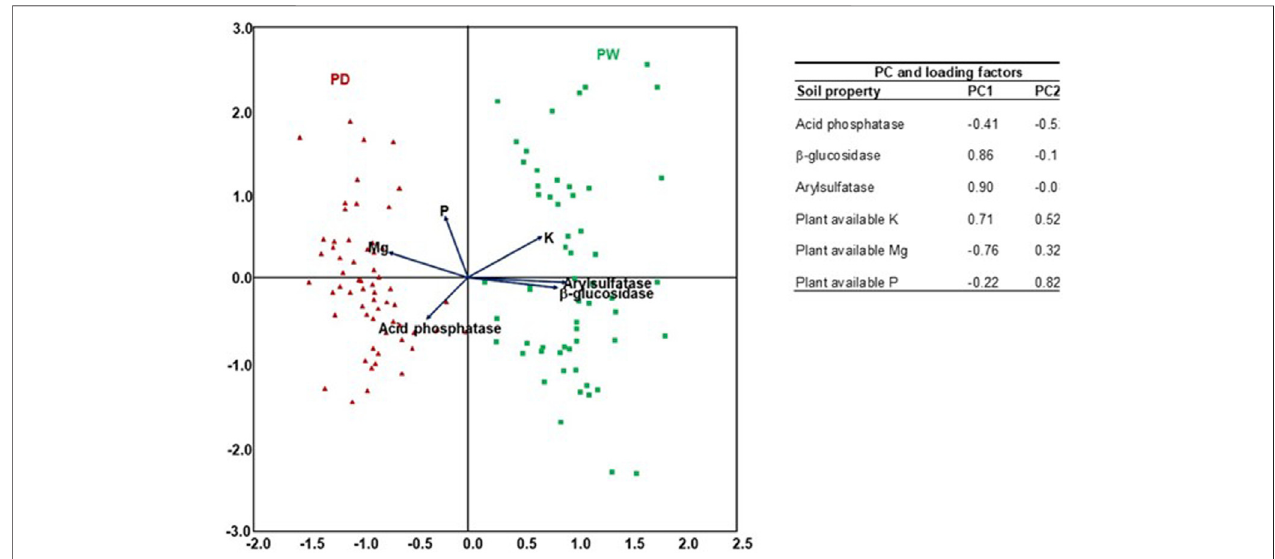
FIGURE4| PCAscatterplotofplantavailablenutrientconcentrationandenzymeactivityinthesurfacehorizonsofthedrainedandrewettedpeatlands.PD:drained peatland, PW: rewetted peatland.